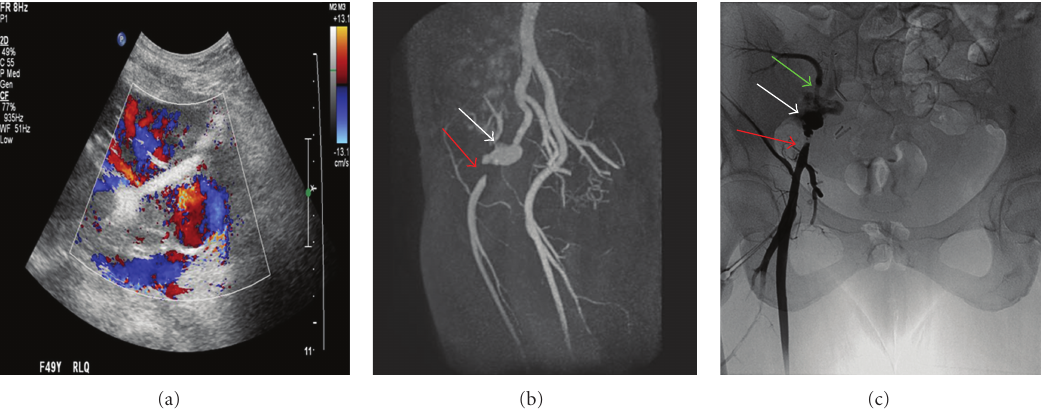
Figure 1: A possible pseudoaneurysm in the region of the vascular anastomosis revealed by Color Doppler Ultrasound (a) with an area of turbulent and to-and-fro waveforms. Follow-up MRI (b) confirmed a bilobed pseudoaneurysm (white arrow) and revealed a segment of high-grade stenosis of the right external iliac artery (red arrow). Conventional angiogram image (c) in AP view reconfirmed the pseudoaneurysm (white arrow) and a segment of high-grade stenosis of the right external iliac artery (red arrow) with stenosis of the transplanted renal artery (green arrow).